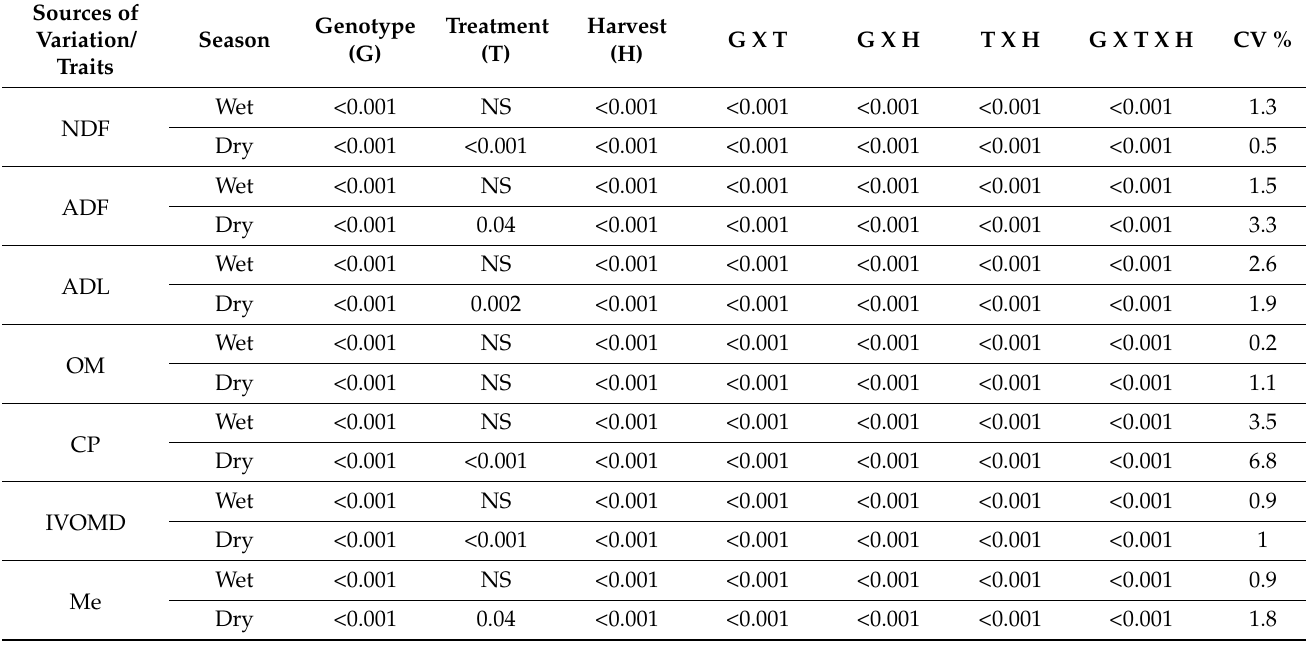
Table 3. Combined ANOVA for seven feed quality traits of Napier grass genotypes grown under rainy season and dry season conditions across six